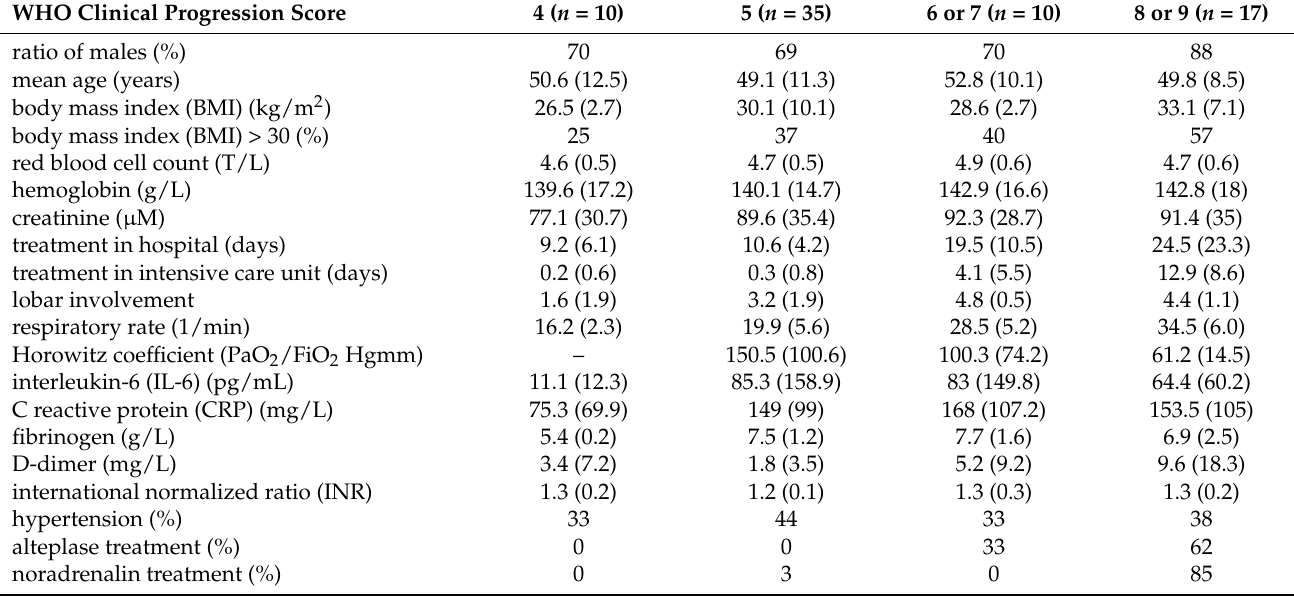
Table 2. Clinical and biological characterization of subject cohorts. Participants of the study were ordered into severity cohorts according to WHO clinical progression scores [37]. Subjects with scores of 6 or 7 and 8 or 9 were classified in a common cohort, respectively, in order to guarantee that all cohorts included at least ten members for sufficient statistical significance. Lobar involvement corresponds to the number of infiltrated lung lobes. Standard deviations are shown in